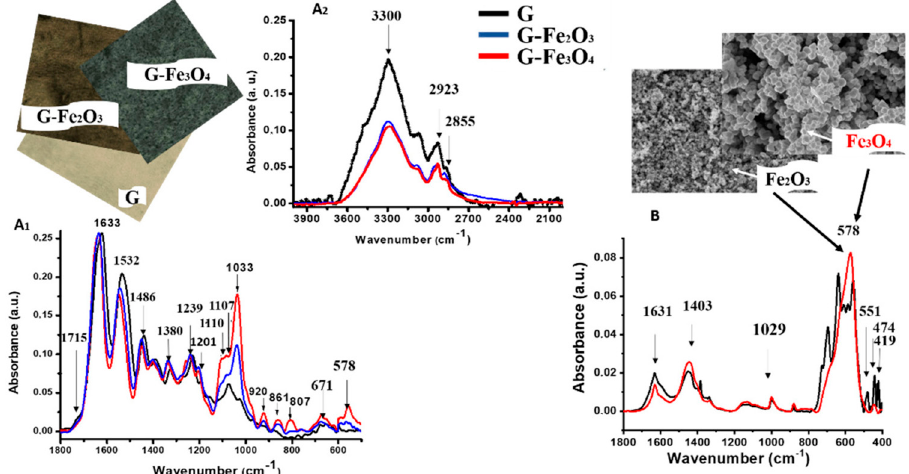
Figure 3. ATR-FTIR spectra of gelatin-based materials (G, G–Fe 2 O 3 and G–Fe 3 O 4 ) in the range: 4000–2100 cm − 1 ( A1 ) and 1800–500 cm − 1 ( A2 ); ( B ) FTIR spectra of pure Fe 2 O 3 and Fe 3 O 4 nanoparti- cles in the range: 1800–500 cm − 1